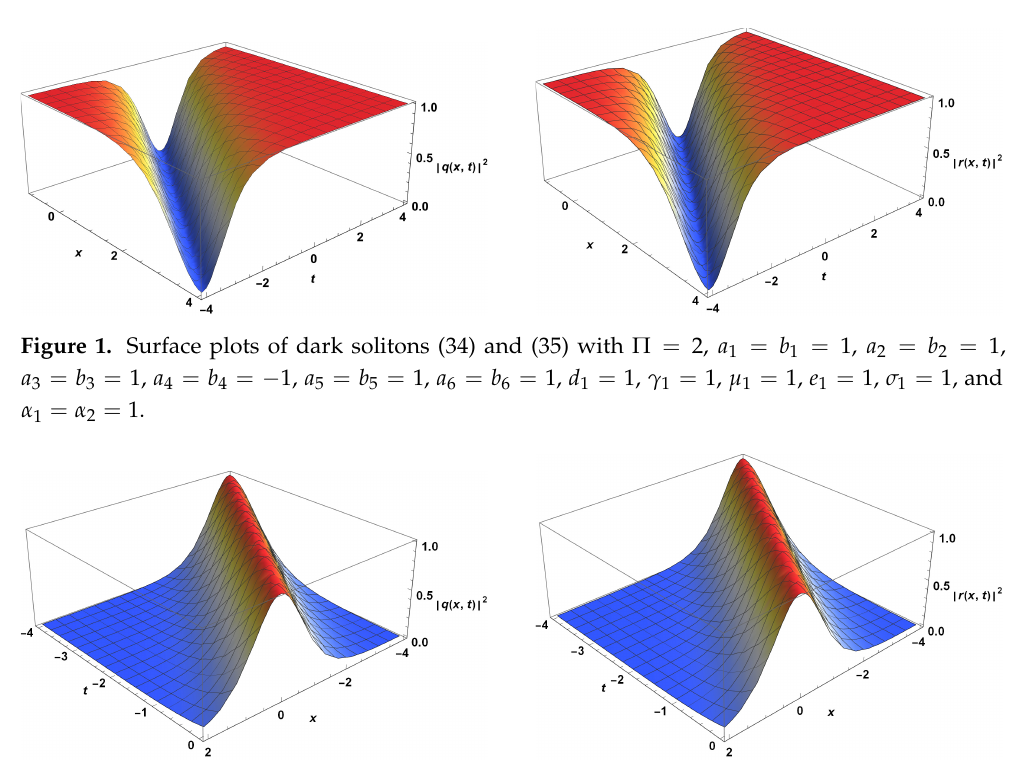
Figure 2. Surface plots of bright solitons (51) and (52) with a = e , Π = 2, a 1 = b 1 = 1, a 2 = b 2 = 1, a 3 = b 3 = 1, a 4 = b 4 = − 1, a 5 = b 5 = 1, a 6 = b 6 = 1, d 1 = 1, γ 1 = 1, µ 1 = 1, e 1 = 1, σ 1 = 1, and α 1 = α 2 =